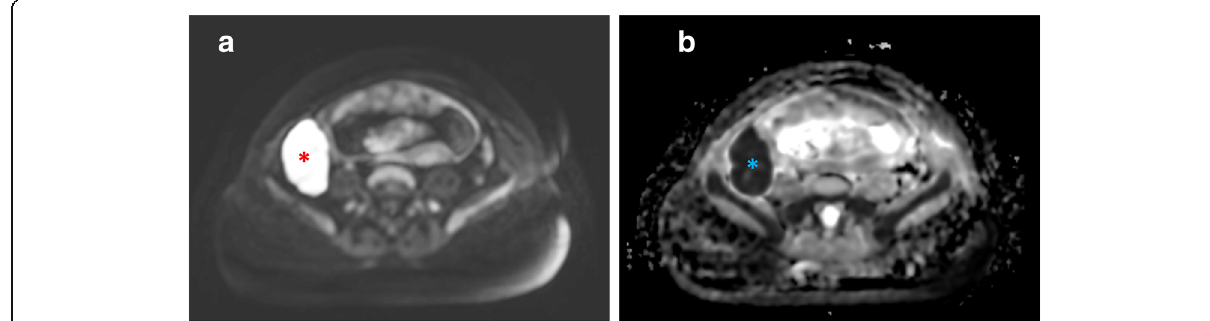
Fig. 3 The tumor presents restricted diffusion with high signal intensity on axial diffusion-weighted imaging (b1000) (red asterisk in a ) and low signal intensity on axial ADC map (blue asterisk in b ). This is consistent with the presence of blood content, as identified on T1-weighted